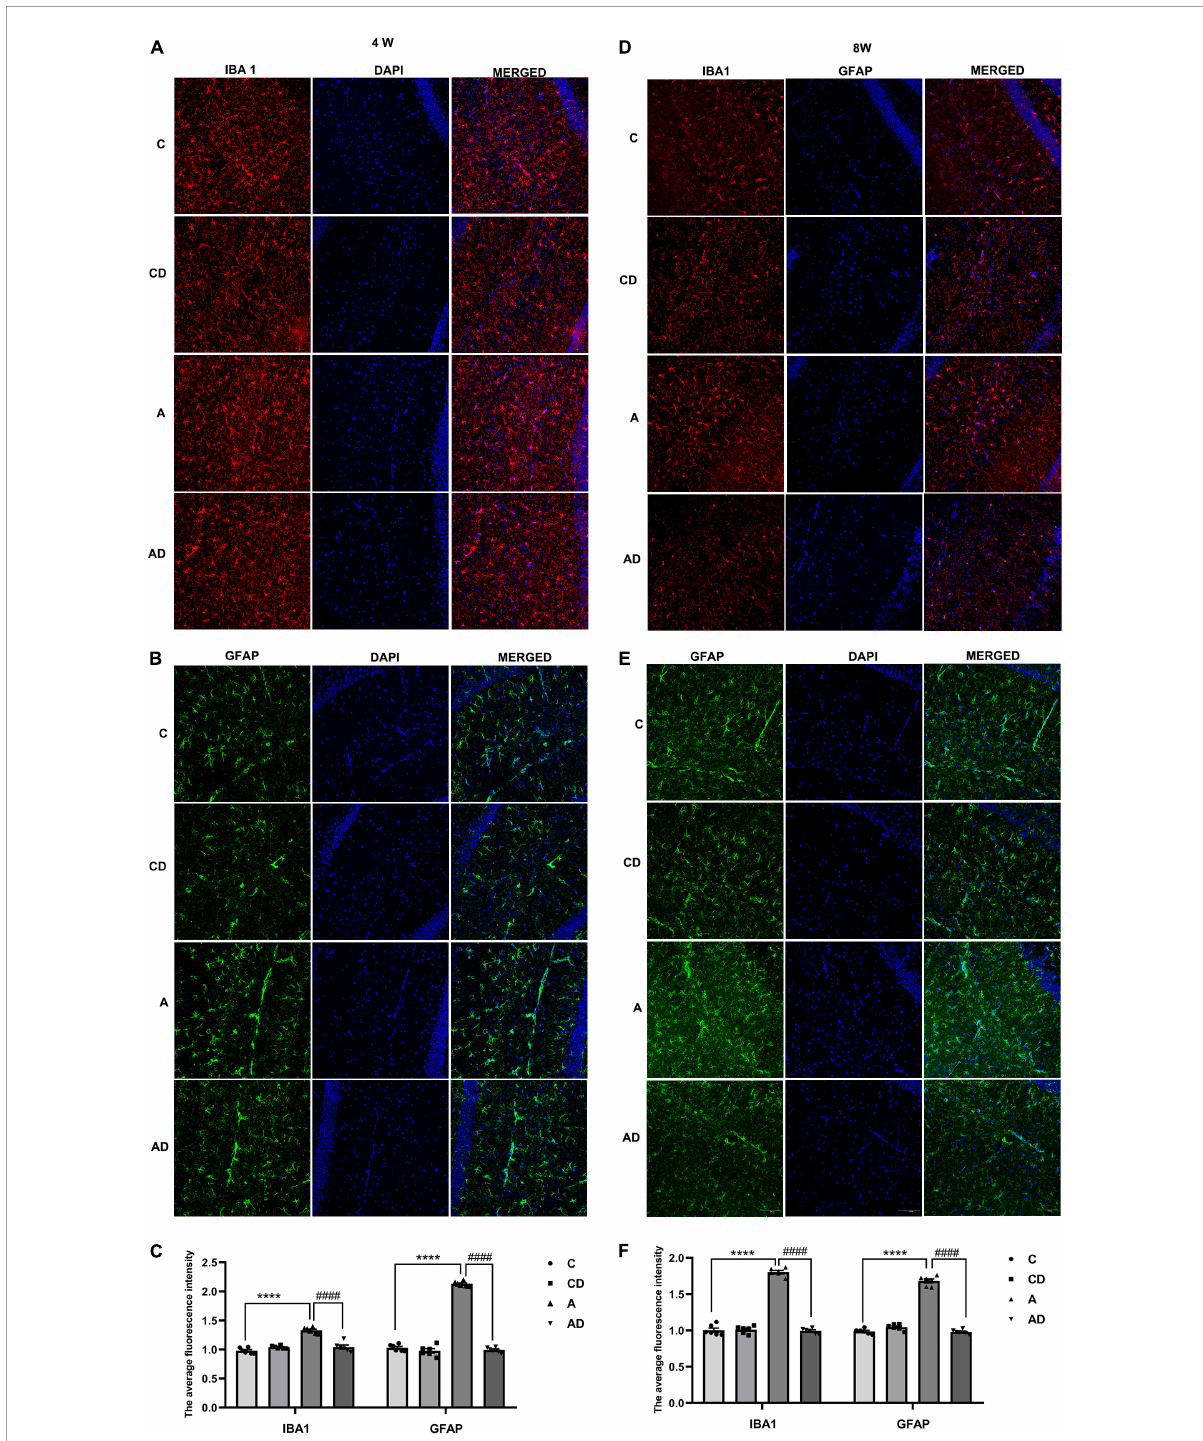
FIGURE5 Effects of Disodium cromoglycate (DSCG) and general anesthesia (GA) on the activation of microglia and astrocyte in hippocampal CA1 region. (A) Representative ionized calcium binding adapter molecule (IBA1) immunostaining images in 4 Weeks. (B) Representative glial fibrillary acidic protein (GFAP) immunostaining images in 4 Weeks. (C) Quantitative data of ionized calcium binding adapter molecule 1 (IBA1) and GFAP immunostaining in 4 Weeks. (D) Representative IBA1 immunostaining images in 8 Weeks. (E) Representative GFAP immunostaining images in 8 Weeks. (F) Quantitative data of IBA1 and GFAP immunostaining in 8 Weeks. Scale bar = 100 µ m. Results are median ± S.E.M ( n = 6) with the presence of individual animal data in the bar graphs. Results were analyzed by one-way analysis of variance (ANOVA) followed by the Tukey’s test. **** P < 0.0001 compared with C group. #### P < 0.0001 compared with A